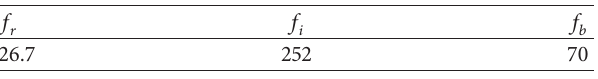
Table 2: Characteristic frequencies of the bearing